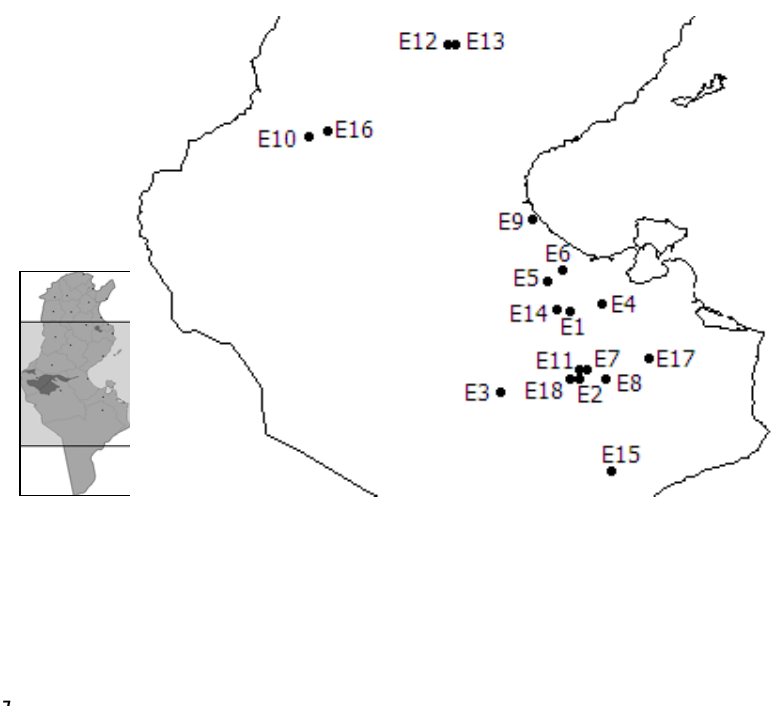
Figure 1. Origins of Artemisia herba-alba